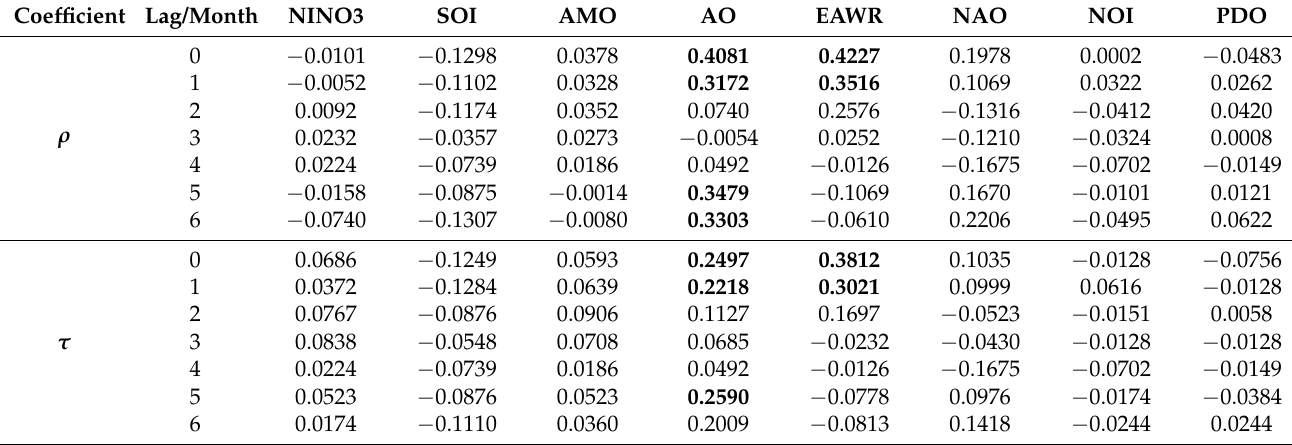
Table A2. The Pearson correlation coefficient ρ and the Kendall correlation coefficient τ between the time series of wintertime precipitation and climate indices under lags from 0- to 6- month. Bold means statistically significant at the level of 0.05.